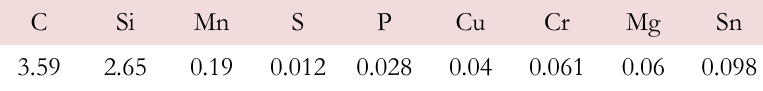
Table 1: Investigated fully pearlitic DCI chemical composition (EN GJS 700-2).